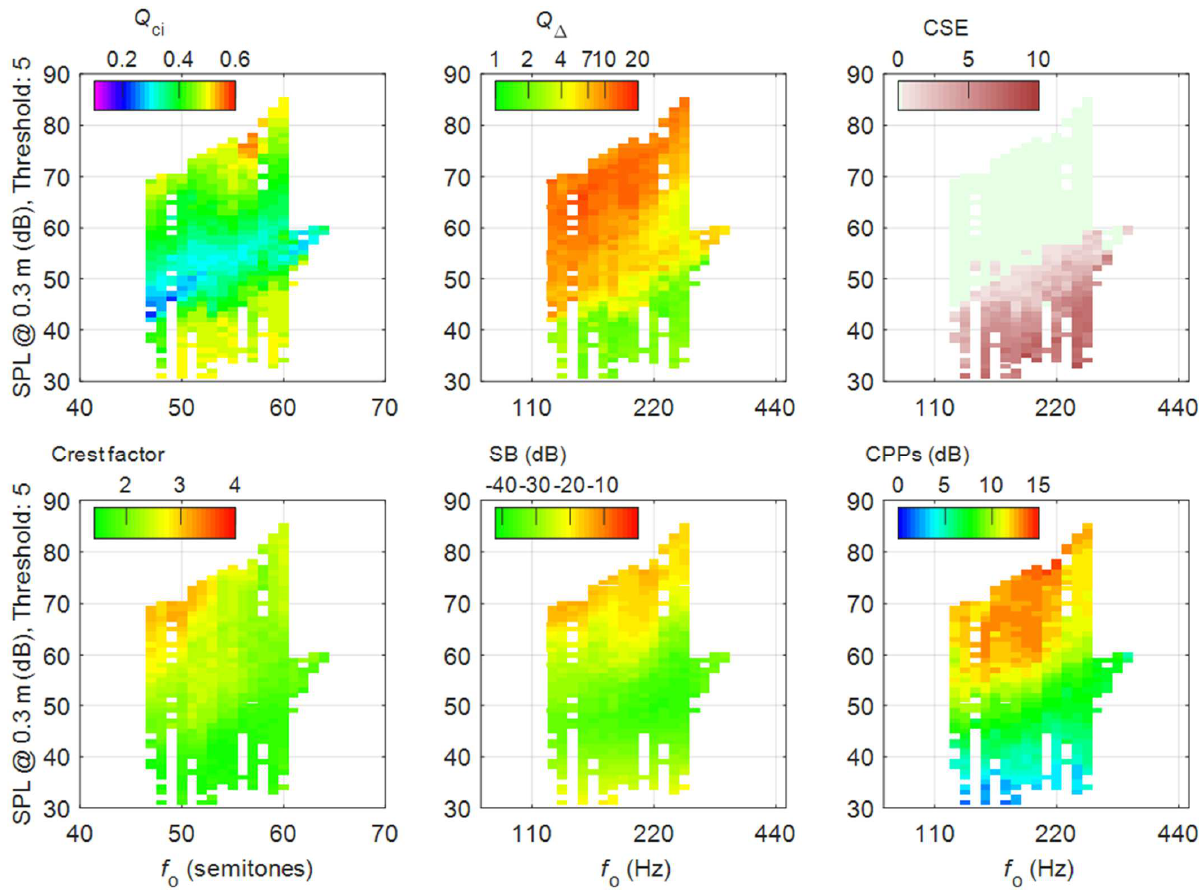
Figure 1. Six layers of a voice map, each layer showing values of one metric, averaged per cell. In the top row are three EGG metrics, and in the bottom are three acoustic metrics. An amateur choir baritone sang messa di voce on the vowel /a:/, with increasing and decreasing SPL on tones spanning just over one octave. Data from Selamtzis and Ternström [15].